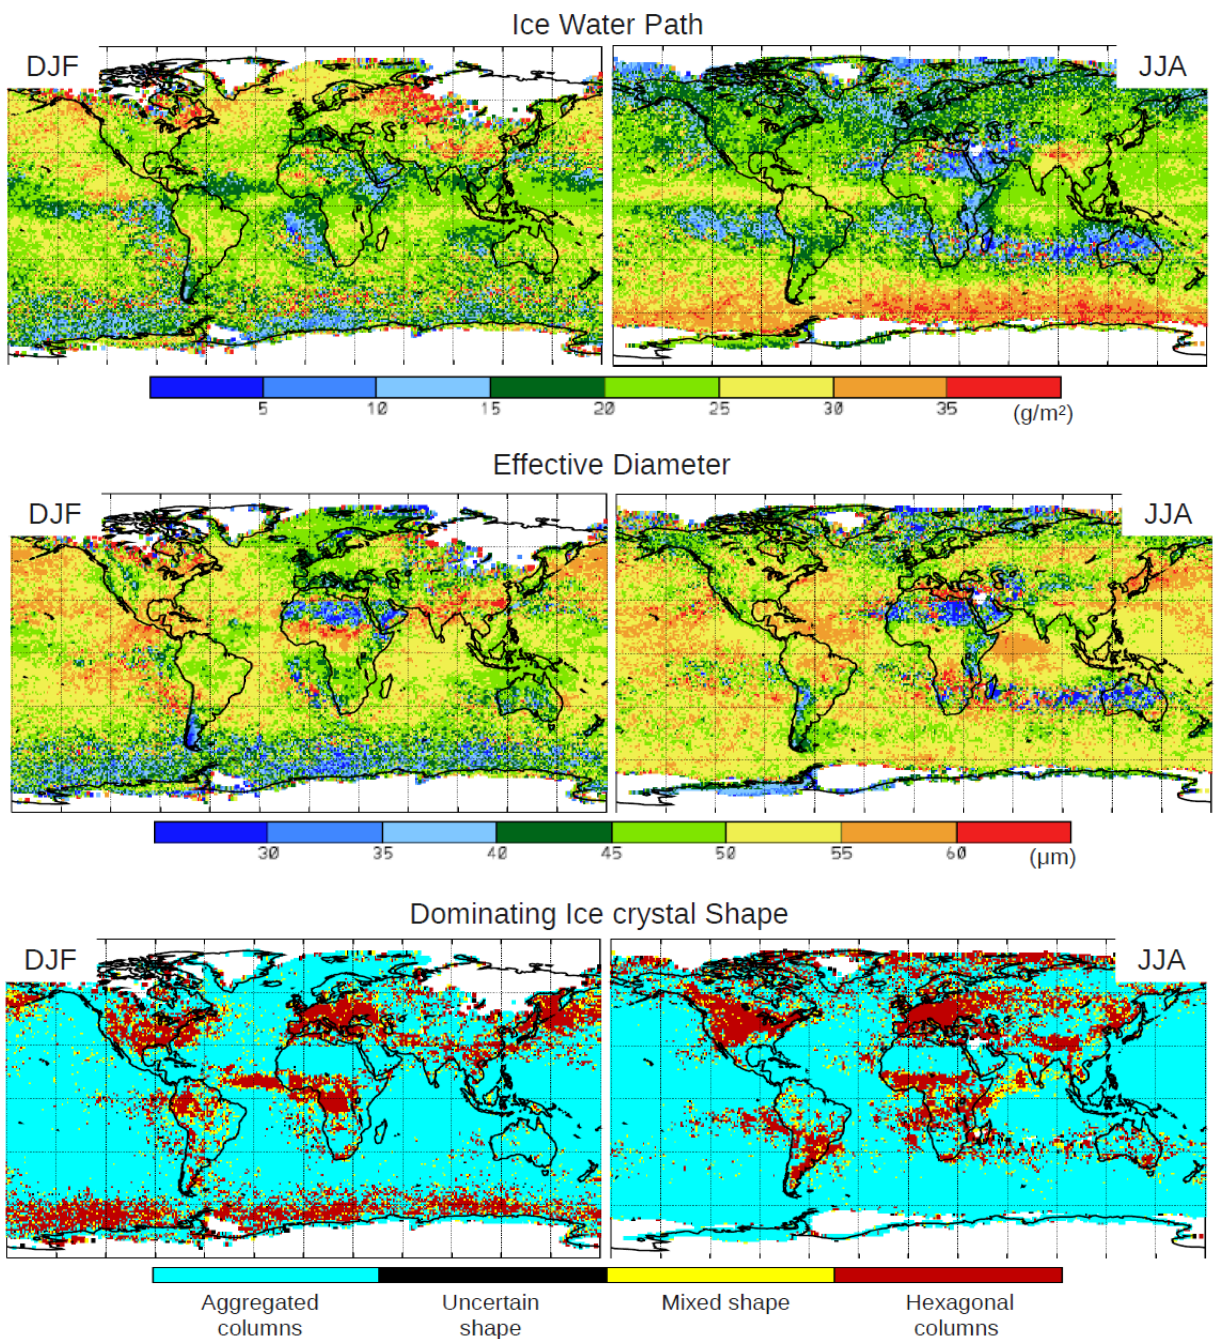
Fig. 9. Geographical maps of ice water path (top), effective ice crystal diameter (middle) and of dominating (occurrence larger than 40%) ice crystal habit (bottom), for boreal winter (left) and boreal summer (left). Statistics is averaged over the period 2003-2009.